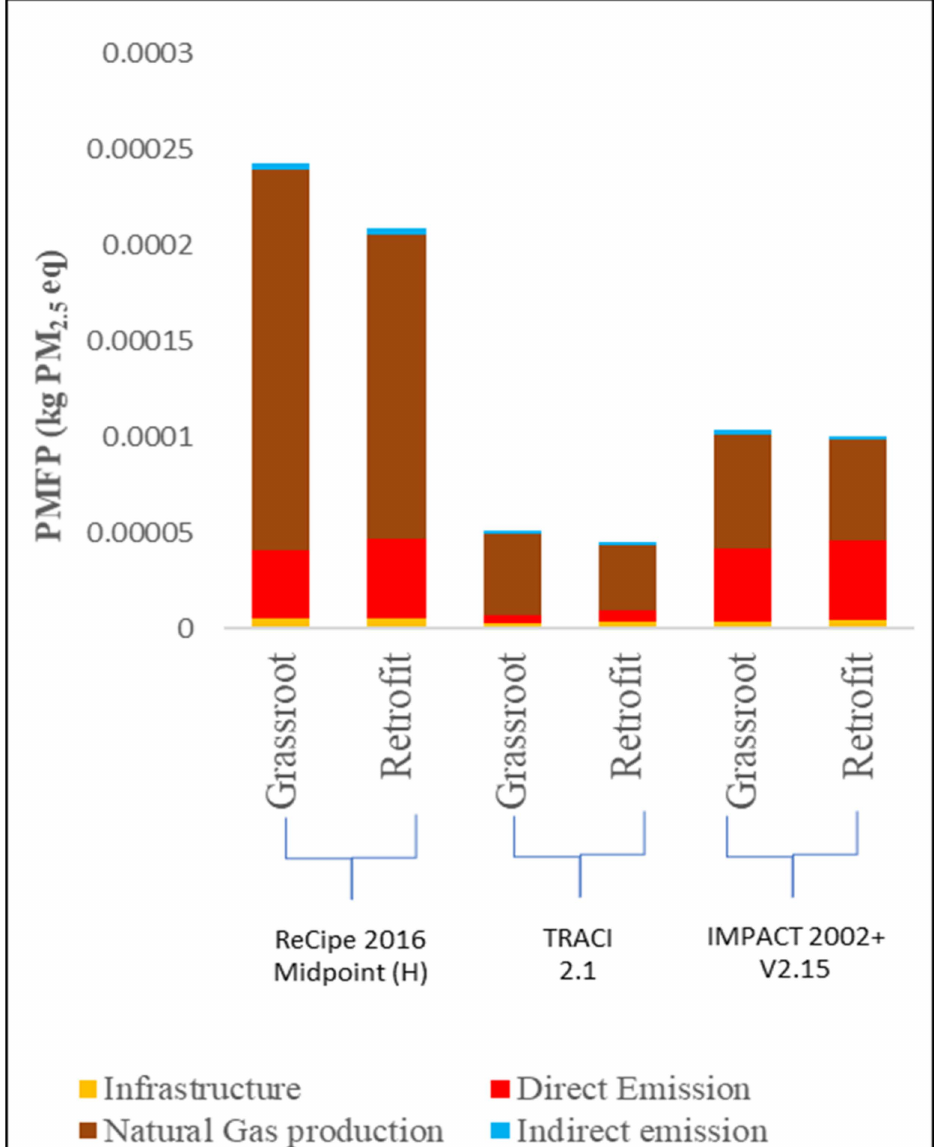
Figure 8. PMFP impact score and process